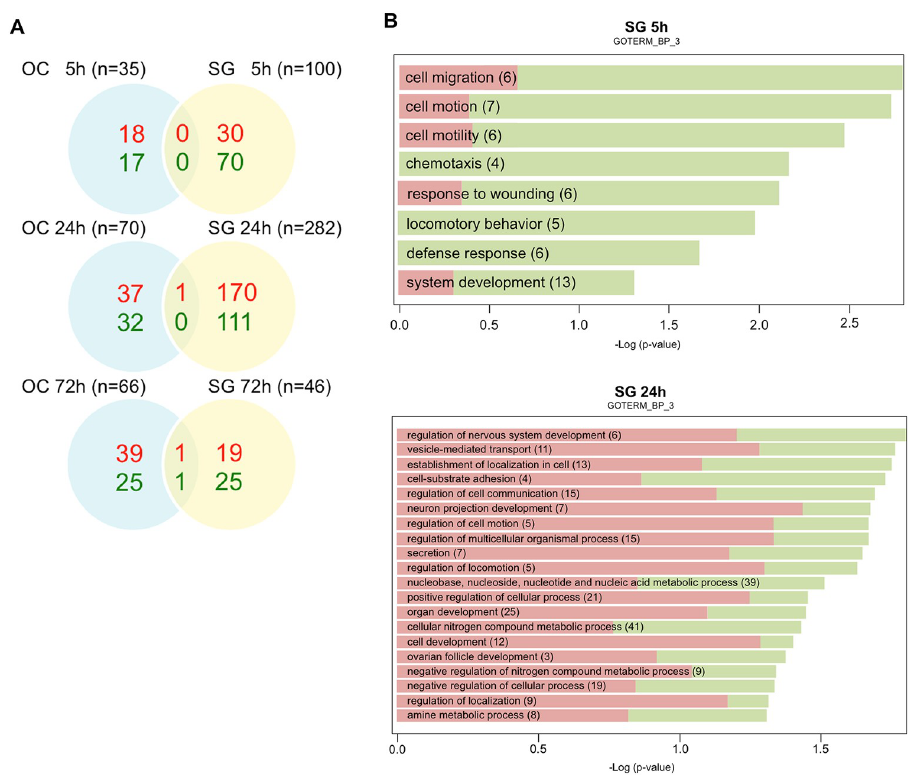
Fig 3. Gene expression changes in cochlear explants after kainate treatment. (A) Differentially expressed genes after kainate treatment. mRNA from spiral ganglion neurons versus organ of Corti fractions was analyzed with microarrays at 5, 24, and 72 h after kainate treatment. Venn diagrams represent the numbers of transcripts that were either upregulated (red) or downregulated (green) at a significance of p < 0.005 following kainate treatment relative to untreated controls at 5, 24, and 72 hours after treatment. (B) Gene Ontology (GO) analysis representing the major biological processes involved in the SG tissues at 5 and 24 h after kainate treatment. Over-represented GO categories among differentially expressed (DE) genes (in green the proportion of downregulated DE genes; in red the proportion of upregulated DE genes) sorted by -log10 (p value). The value 1.3 on the horizontal axis corresponds to p = 0.05. OC, organ of Corti; SG, spiral ganglion.